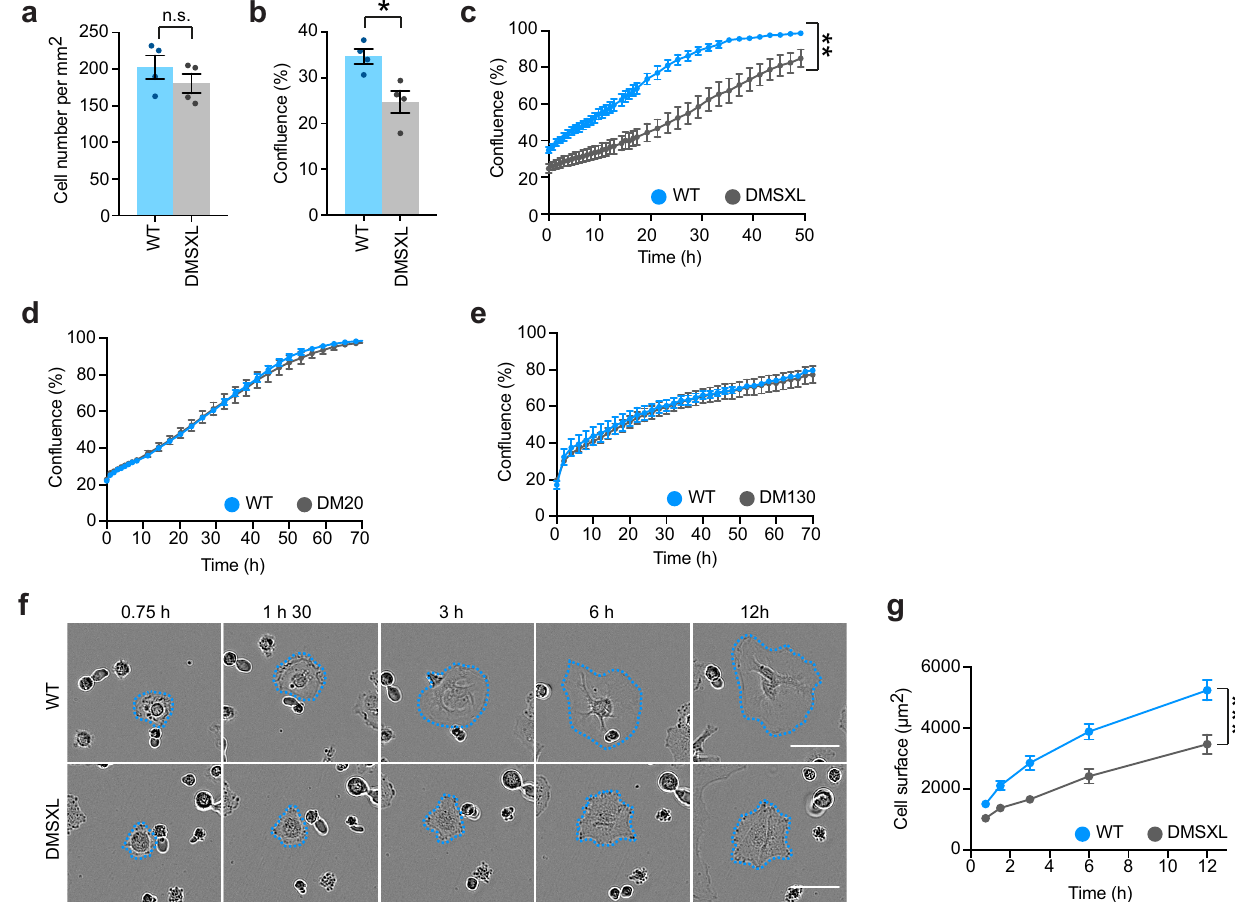
Fig. 3 Primary DMSXL astrocytes exhibit abnormal adhesion and spreading. a Quanti fi cation of the number of DMSXL and WT astrocytes attached 45 min after plating. Data are means ± SEM, n = 4 independent cultures per genotype ( p = 0.3429, Mann – Whitney U test). b Semi-automated quanti fi cation of cell culture con fl uence 45 min after plating. Data are means± SEM, n = 4 independent cultures per genotype ( p = 0.0286,